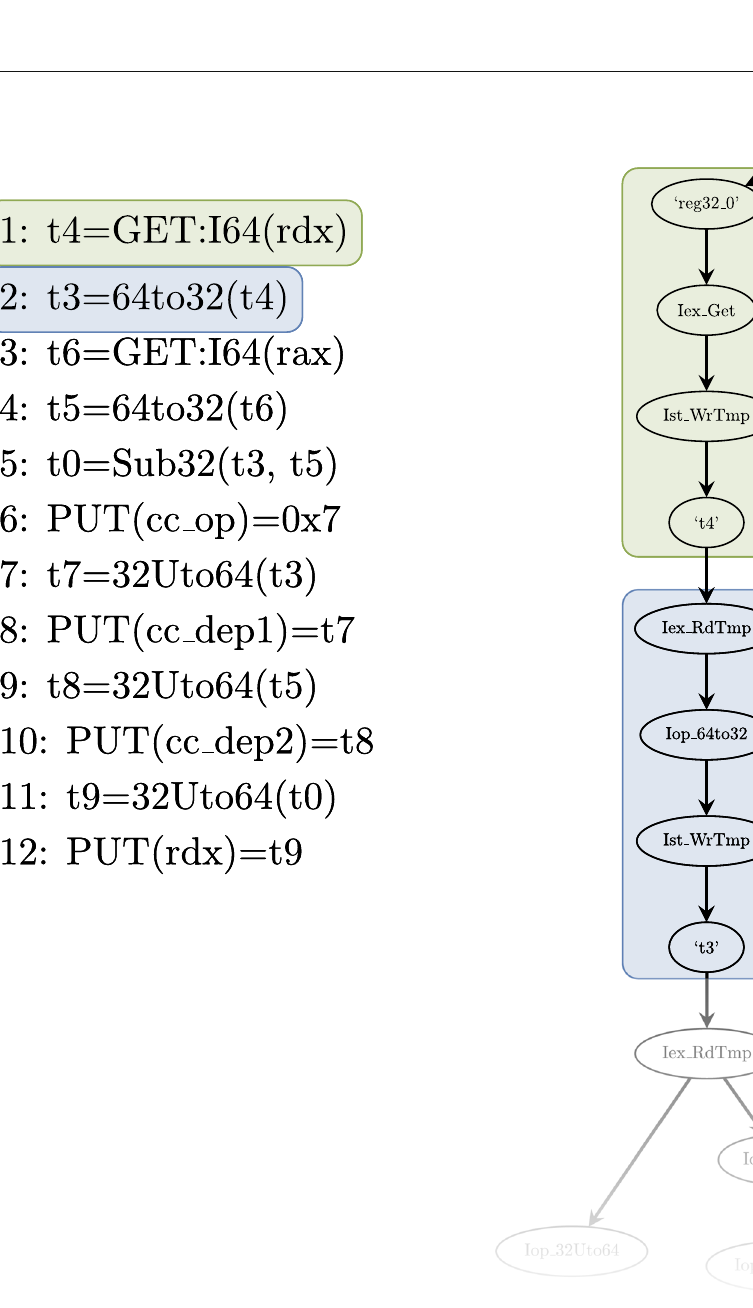
Fig. 2 An example of the program graph. Parts of the graph are highlighted in the same color, as instructions on lines 1 and 2, to demonstrate where those instructions were mapped to in the graph